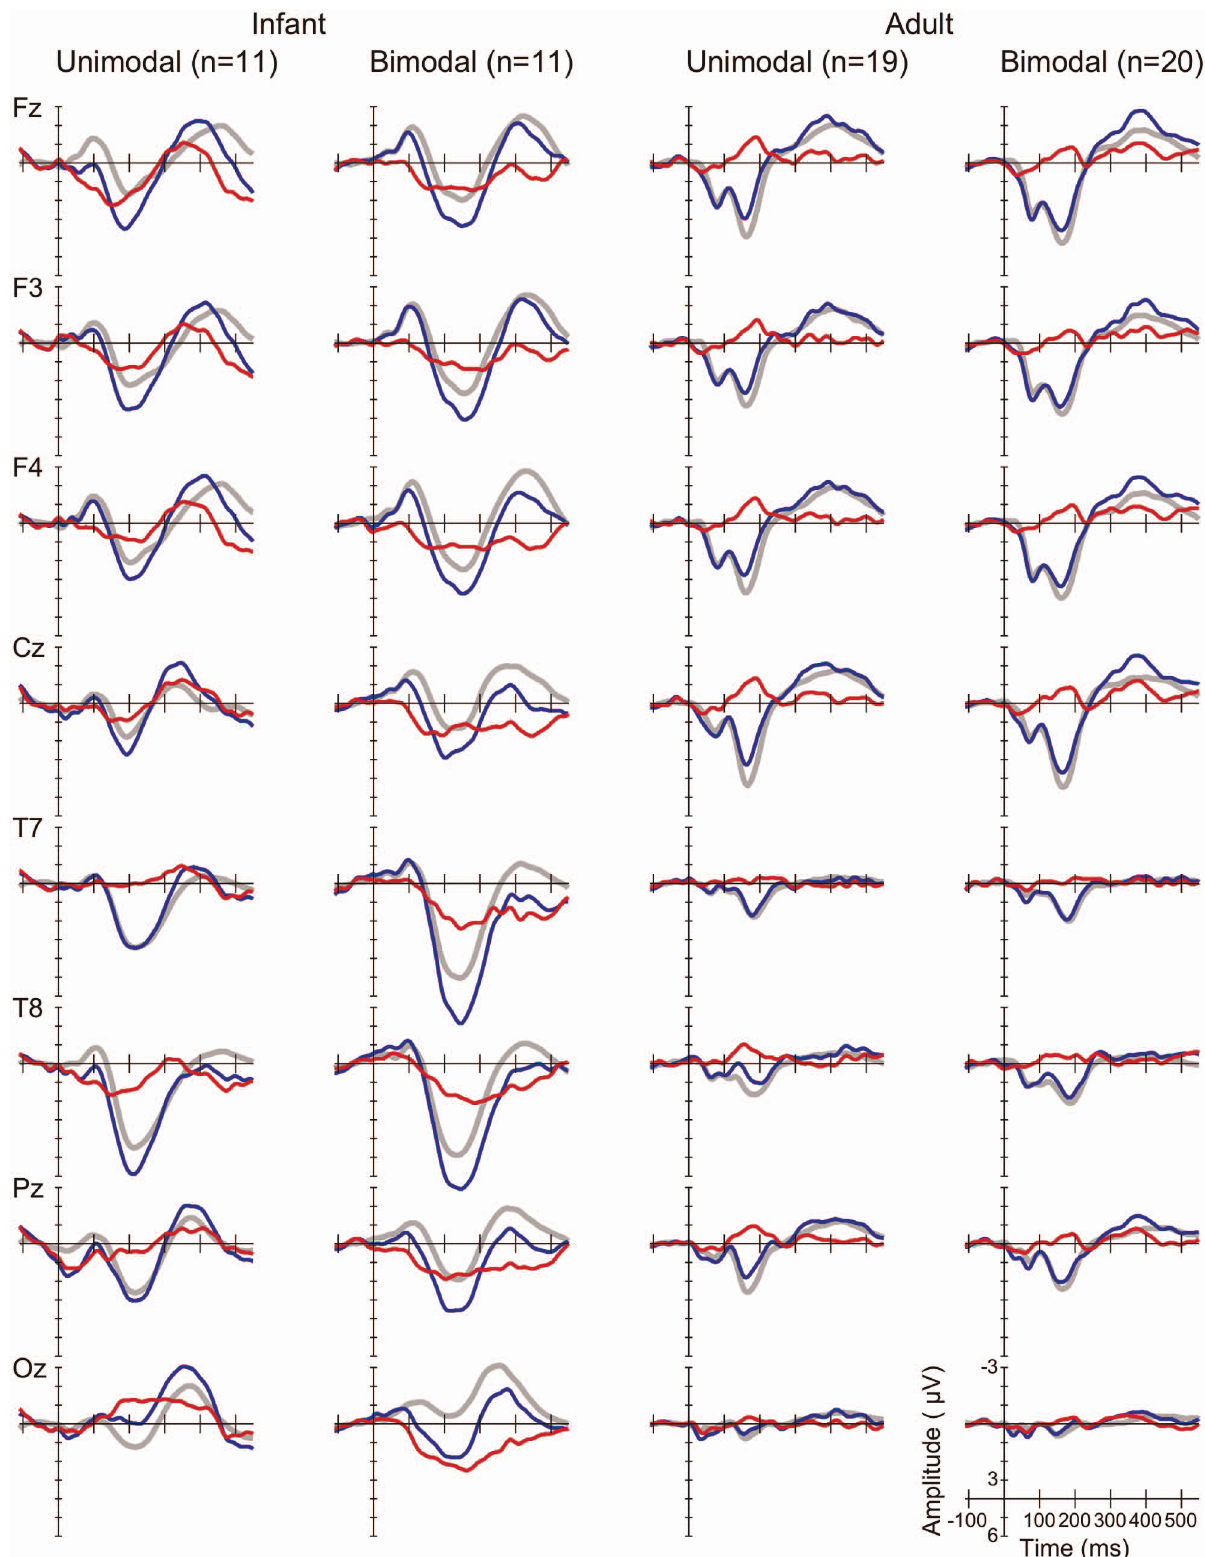
Figure 2. Grand average waveforms. Standard (grey, thick curves), deviant (blue, thin curves) and MMR (red, thin curves), at eight electrodes (see rows), for the unimodally and bimodally trained infants in [4] (the two columns on the left) and adults in the current study (the two columns on the right).